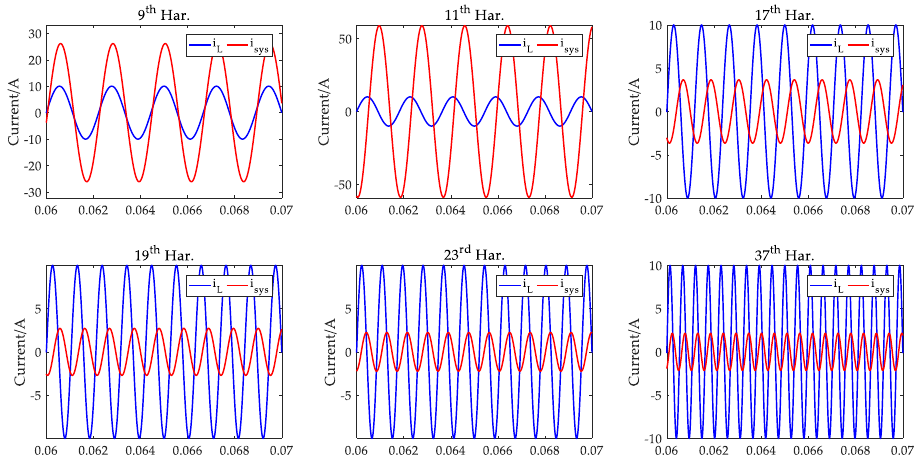
Figure 12. Simulation result of filtering characteristic for the TCL-CTF.